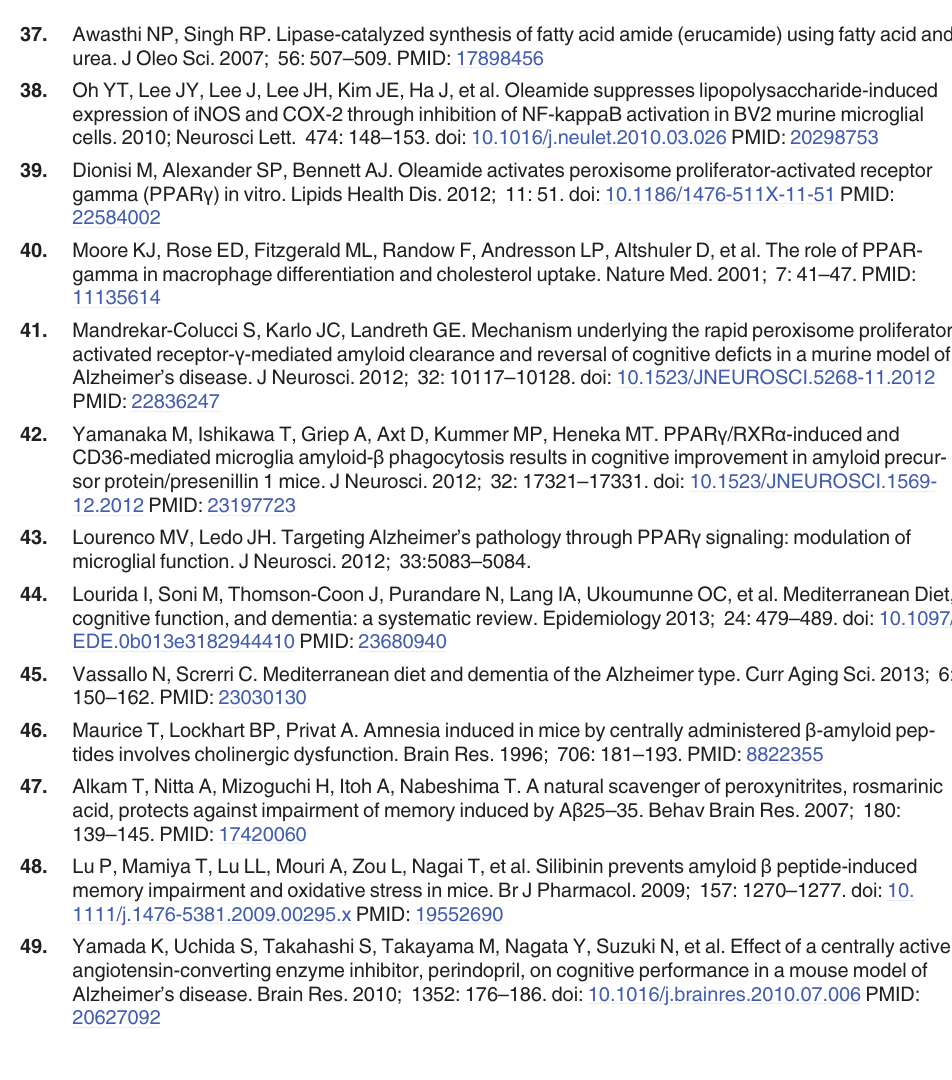
PLOS ONE | DOI:10.1371/journal.pone.0118512 March 11,